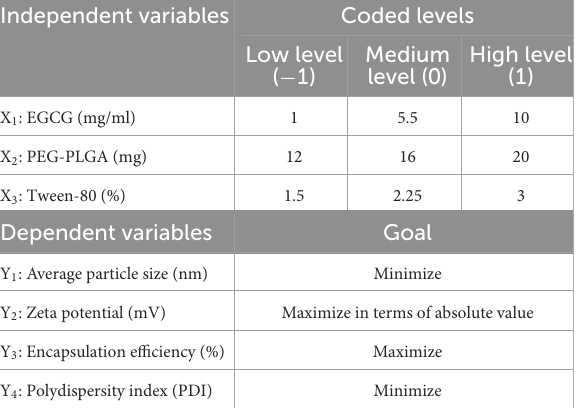
TABLE 1 Box-Behnken design used for optimization of EGCG-loaded formulae. Independent